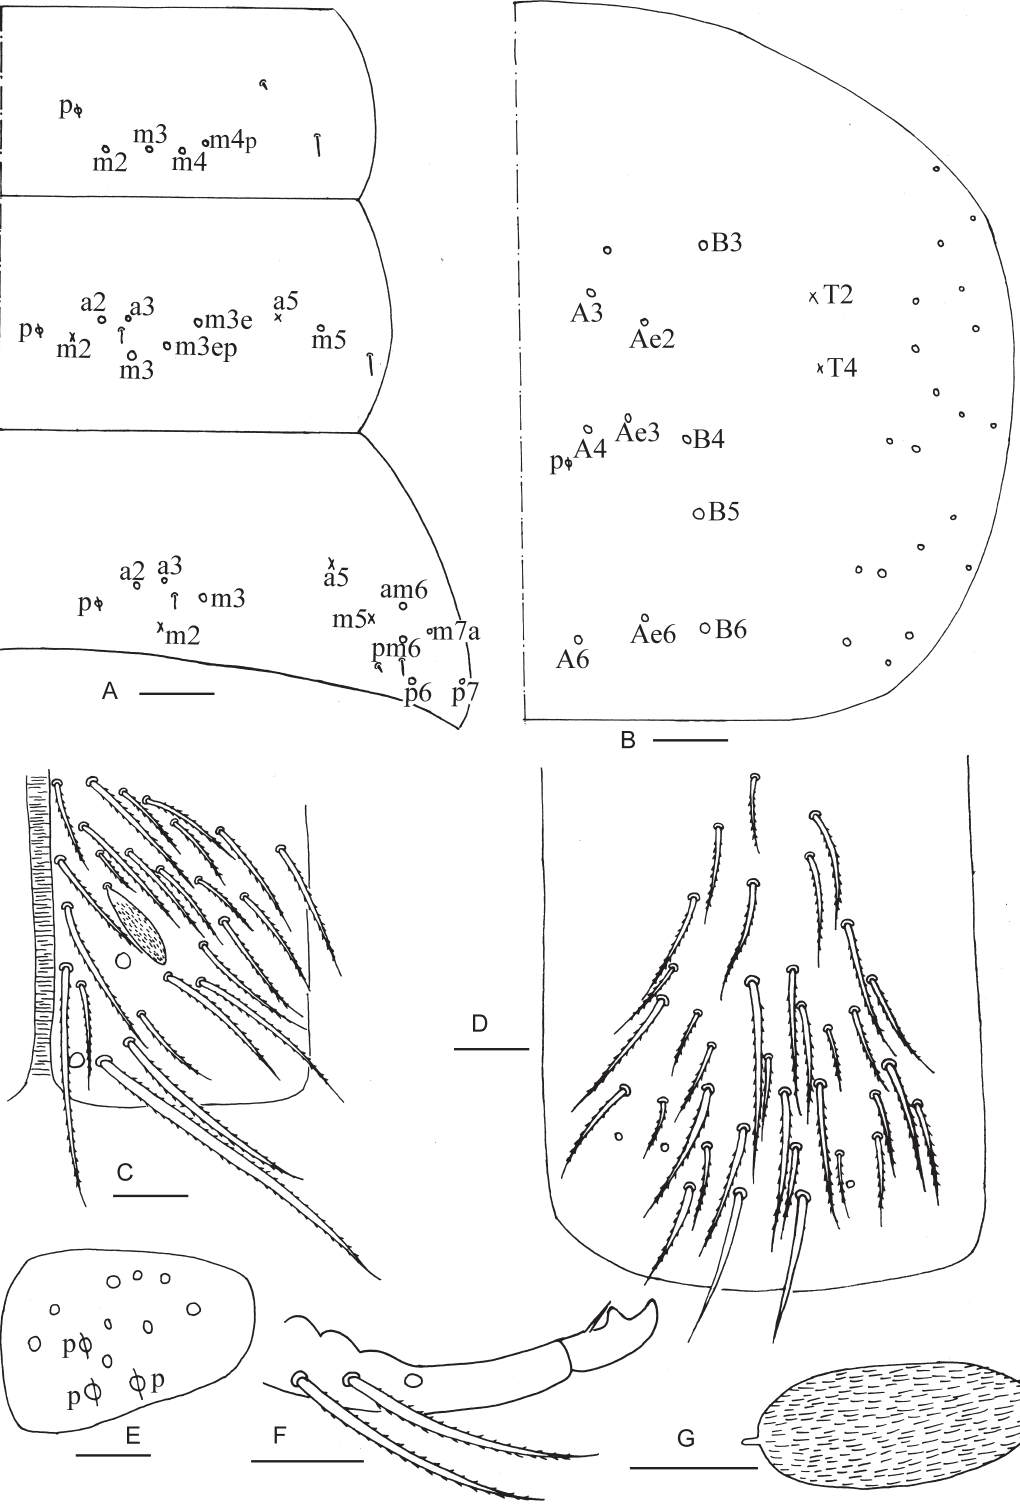
Fig. 6. Willowsia zhaotongensis sp. nov. A . Chaetotaxy of Abd. I−III. B . Chaetotaxy of Abd. IV. C . Anterior face of ventral tube. D . Posterior face of ventral tube. E . Plaque of manubrium. F . Distal part of dens and mucro. G . Scale. Scale bars: A–B = 50 μm; C–G = 15